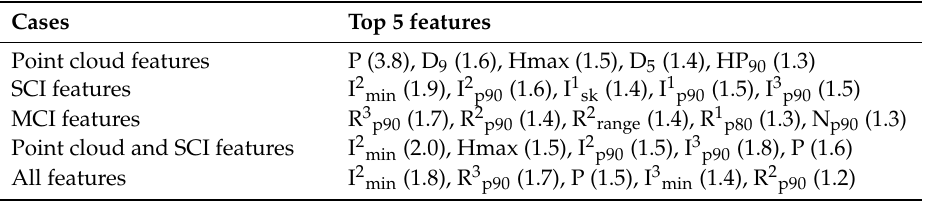
Table 14. The features have the most predictive power in different classification scenarios. A detailed explanation of the features can be found in Table 3. The number in parentheses is the score for the feature. The higher the score, the more important the